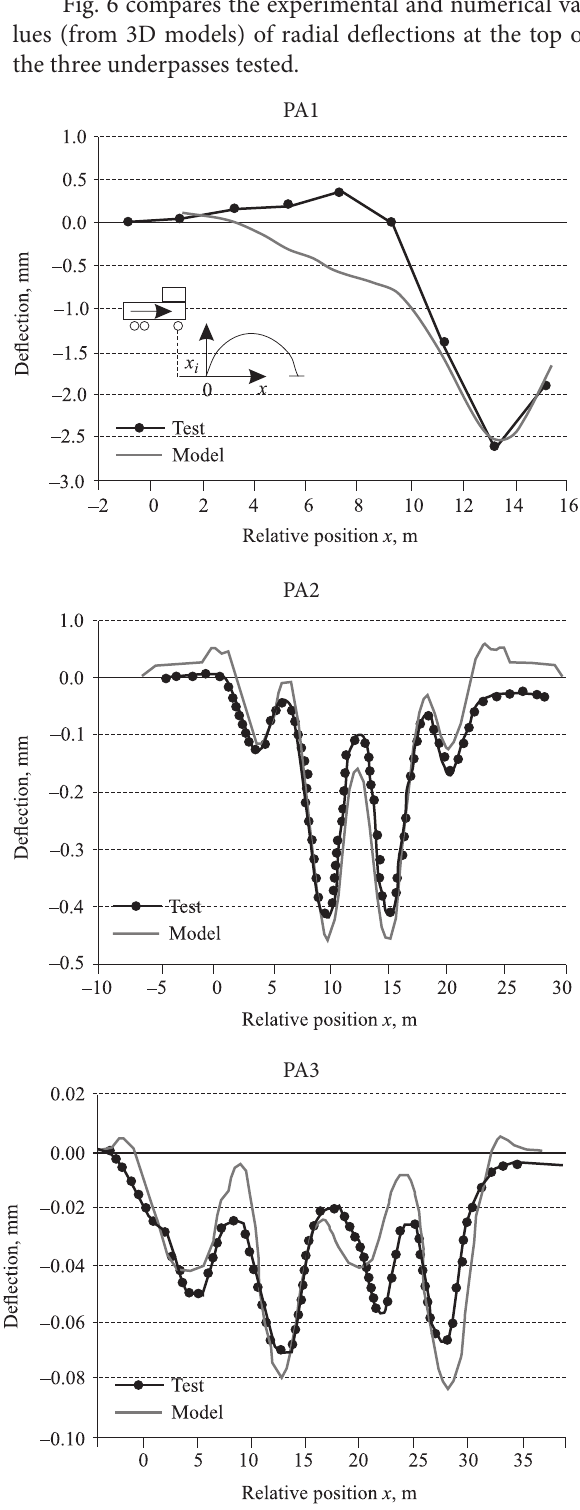
Fig. 6. Comparison of experimental and numerical radial deflections at the top of the three